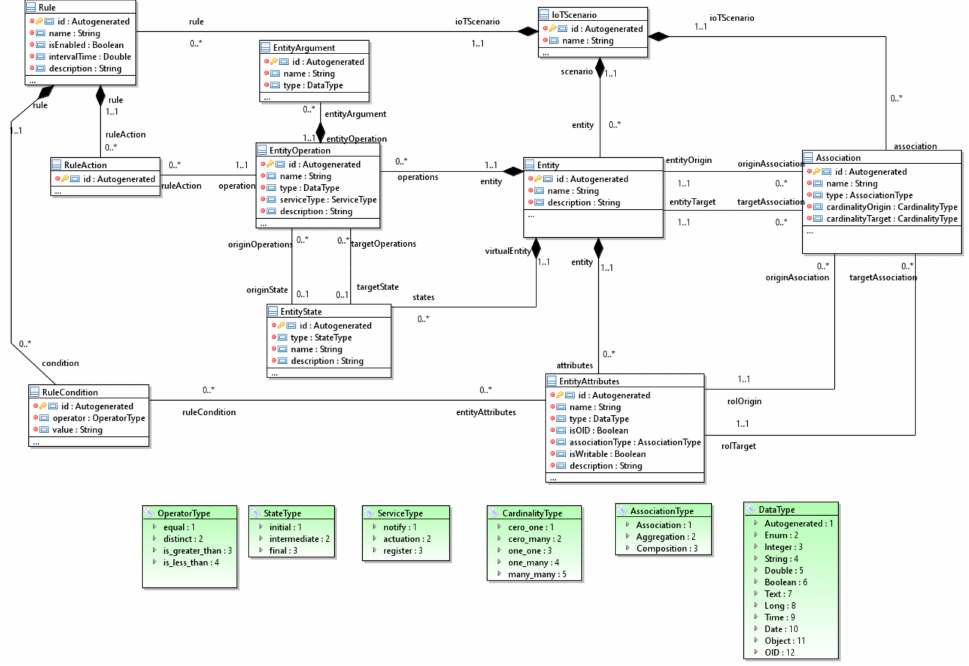
Figure 7. The metamodel core of the MoSIoT scenario